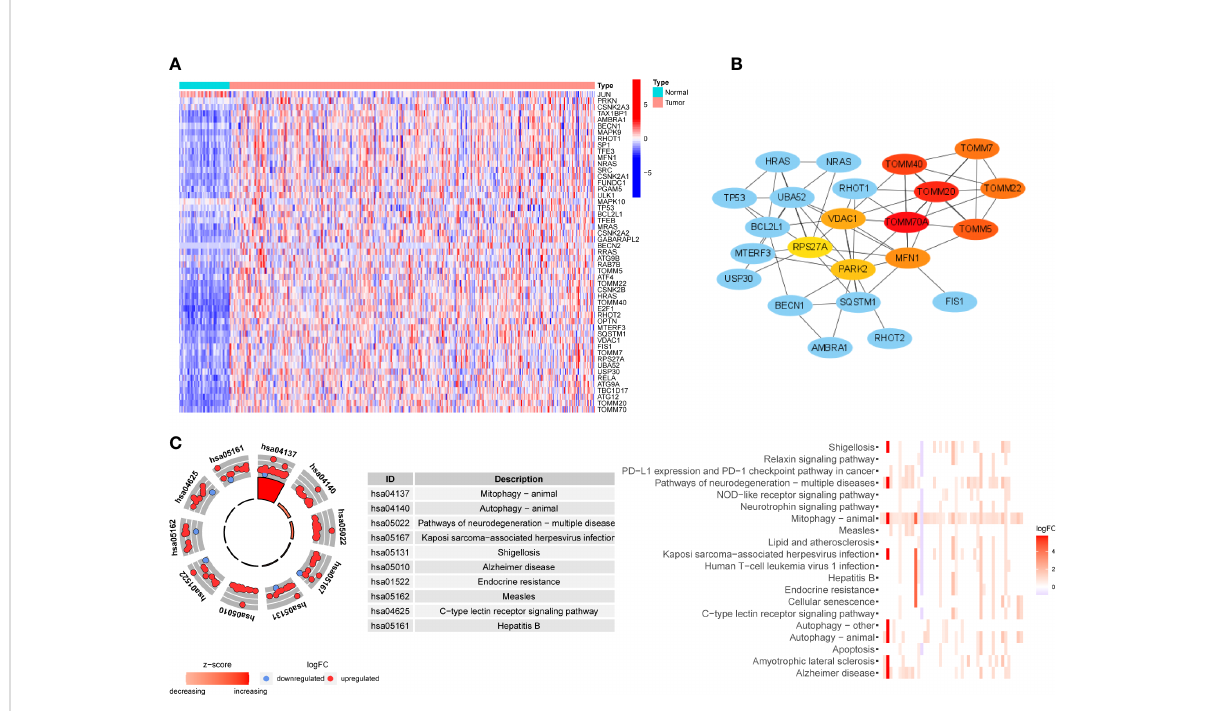
FIGURE 2 Expression level, interactions and functional enrichment analysis of DEMs between tumor samples and normal samples. (A) Pro fi le of DEMs based on sample type. Color represents expression level (blue to red). (B) Hub protein-protein interaction network among DEMs. Color represents con fi dence (blue to red). (C) KEGG analysis of DEMs. DEMs: Differentially expressed mitophagy-related genes, KEGG: Kyoto Encyclopedia of Gene and